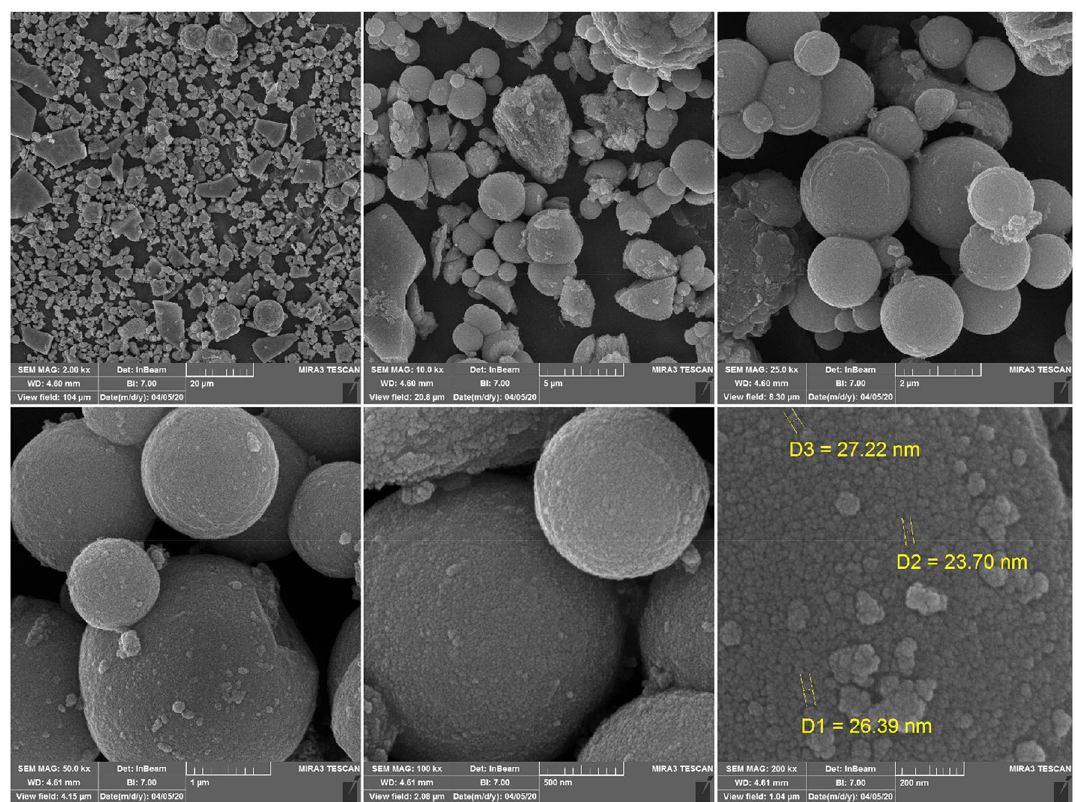
Figure 6. SEM images of three-dimensional walnut-like, hierarchically nanoporous Zn-MOF